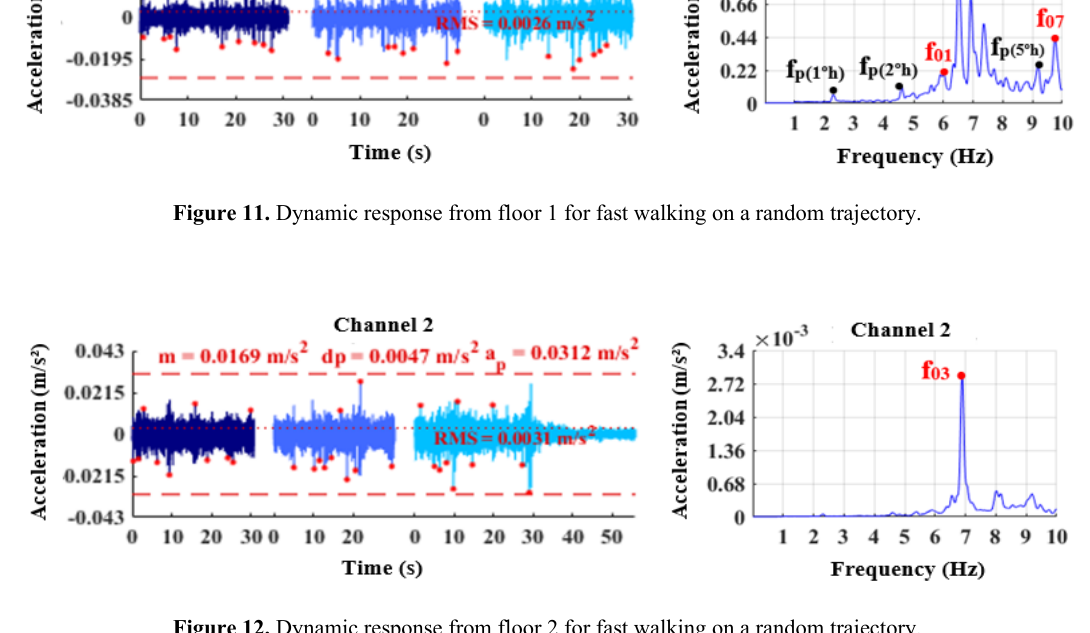
Figure 12. Dynamic response from floor 2 for fast walking on a random trajectory.